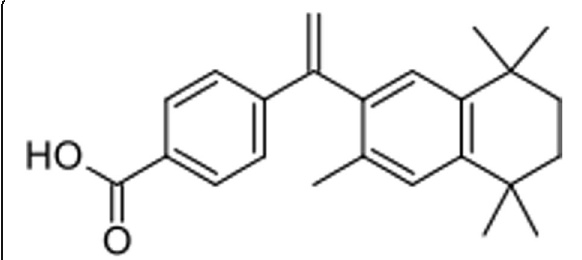
Fig. 1 Chemical structure of bexarotene. Formula: C 24 H 28 O 2 . Molar mass: 348.478